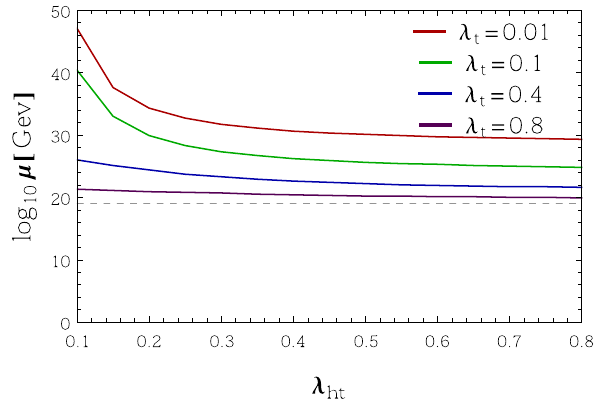
Fig. 5 Two-loop running of the scalar quartic coupling λ ht as a func- tion of perturbative scale. Here red, green, blue and purple curves in each plot correspond to different initial conditions for λ t and λ ht at the EW scale, representative of very weak ( λ t = 0 . 01), weak ( λ t = 0 . 1), moderate ( λ t = 0 . 4) and strong ( λ t = 0 . 8) coupling limits